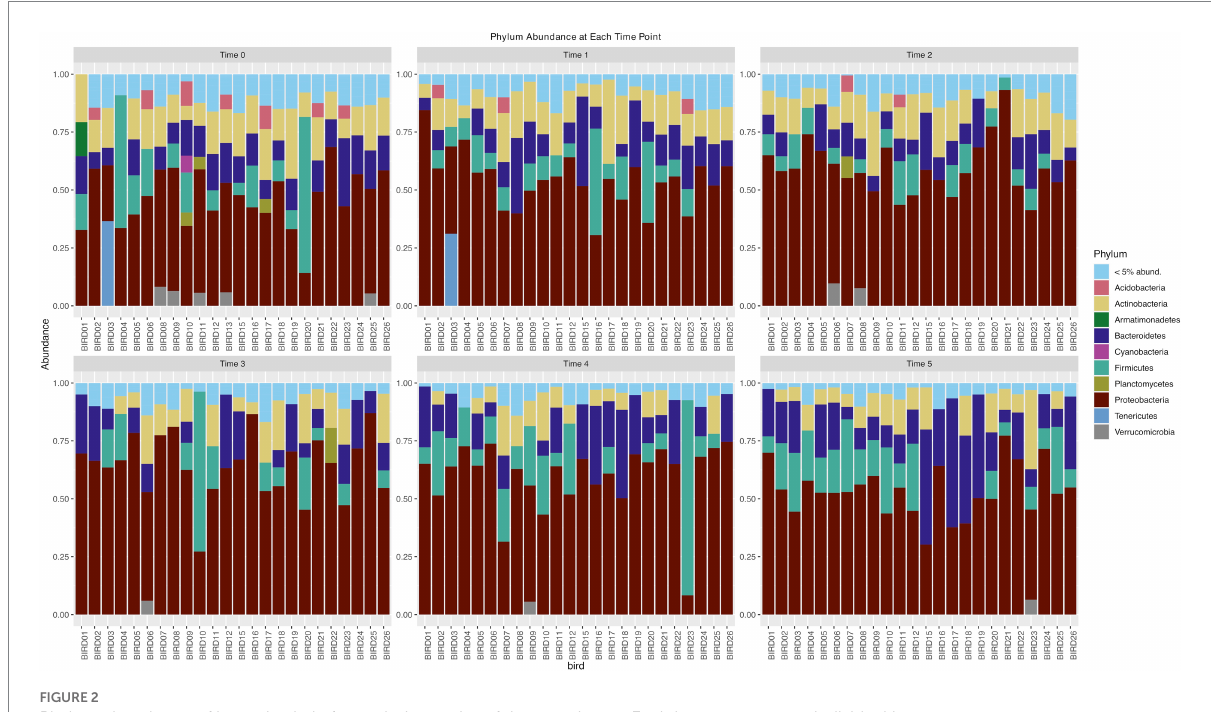
FIGURE 2 Phylum abundance of bacteria phyla for each time point of the experiment. Each bar represents an individual